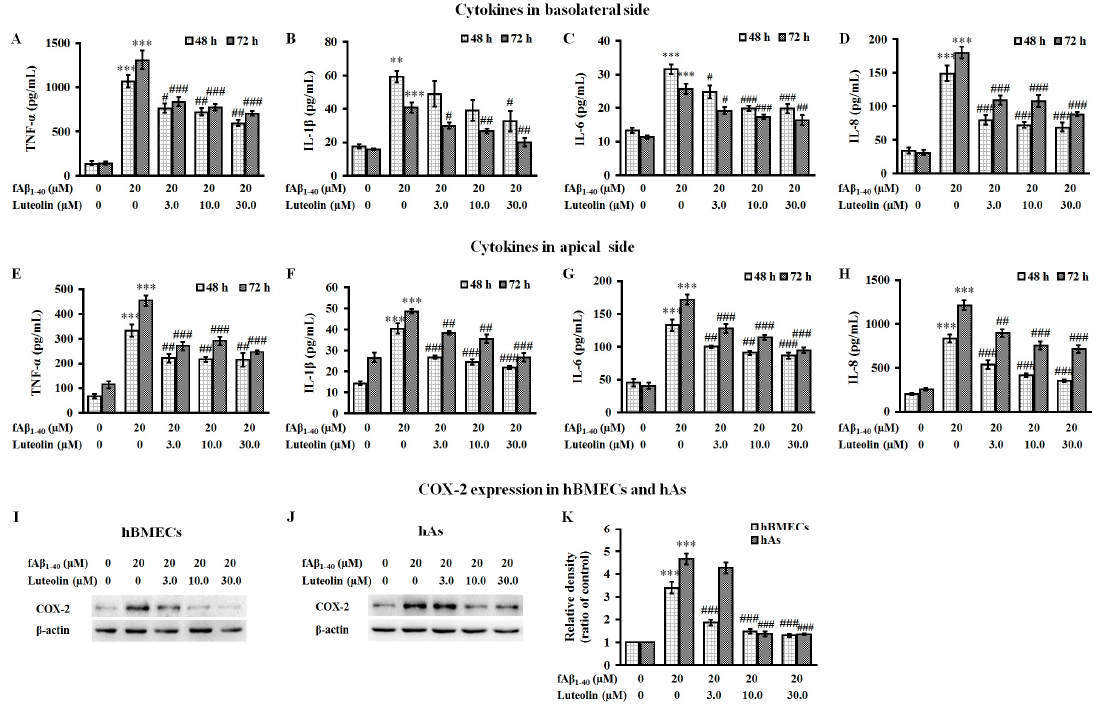
Figure 4. Luteolin inhibits the release of inflammatory cytokines and the expression of cyclooxygenase-2 (COX-2) against fA β 1–40 -induced toxicity. Luteolin decreased the levels of tumor necrosis factor α (TNF- α ) ( A ); interleukin 1 β (IL-1 β ) ( B ); interleukin 6 (IL-6) ( C ) and interleukin 8 (IL-8) ( D ) in the basolateral supernatant and the levels of TNF- α ( E ); IL-1 β ( F ); IL-6 ( G ); and IL-8 ( H ) in the apical supernatant collected at 48 h and 72 h time points following treatment with fA β 1–40 . Data are expressed as the mean ± SEM; n = 4; ** p < 0.01; *** p < 0.001 vs. control; # p < 0.05; ## p < 0.01; ### p < 0.001 vs. fA β 1–40 . Luteolin also down-regulated the expression of COX-2 in cell extracts of hBMECs ( I ) and hAs ( J ) of the co-culture after exposure to fA β 1–40 for 72 h. Relative density values of COX-2 were quantified to intensity levels of β -actin ( K ). Data are expressed as the mean ± SEM, n = 4; *** p < 0.001 vs. control; ### p < 0.001 vs. fA β 1–40 .